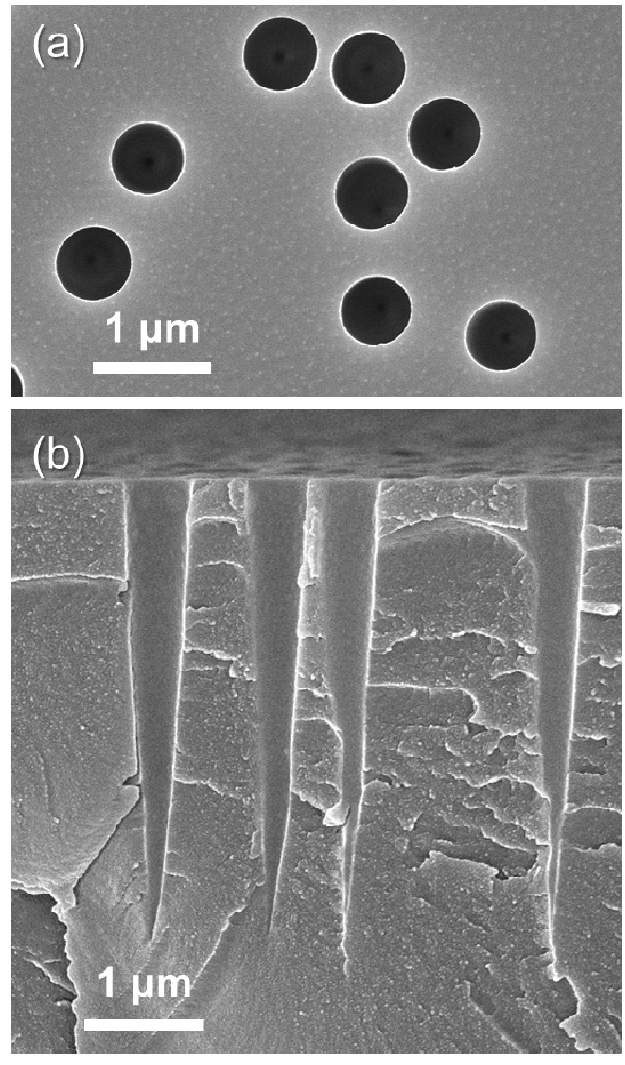
Figure 3. FE-SEM images of ( a ) the surface and ( b ) the cross-section of the PC membrane etched for 30 min in a 4.0 mol/dm 3 NaOH solution at 60 ° C.